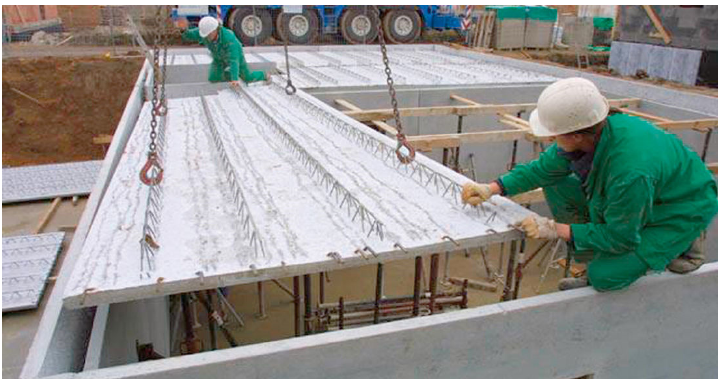
Figure 3. Filigree ceiling on the construction site.